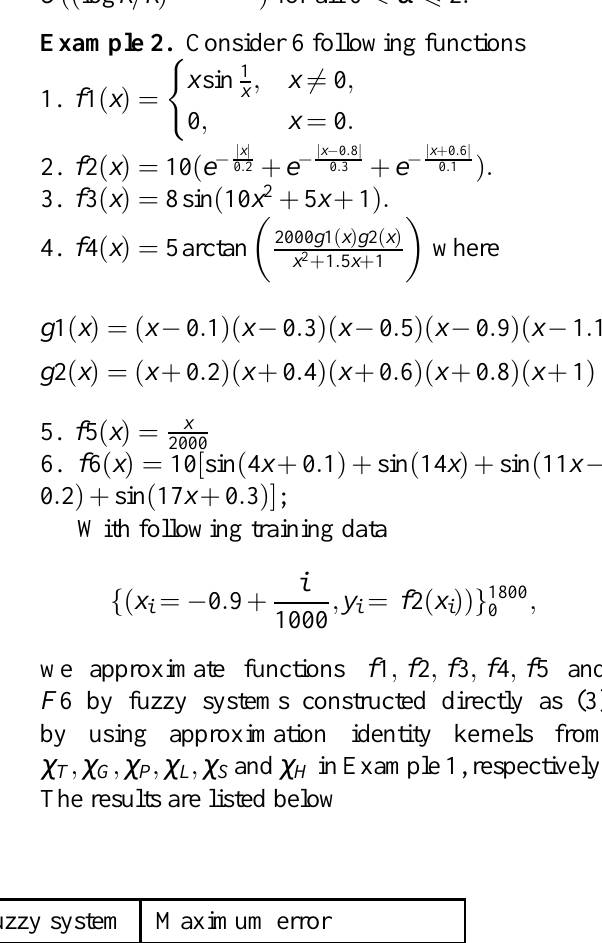
Fig. The curve of target function and fuzzy system Maximum